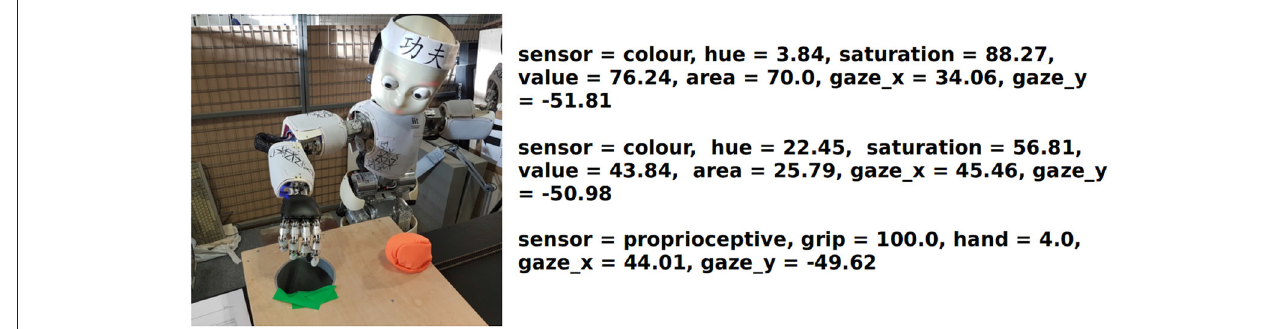
FIGURE 10 | Experimental set up for the iCub and perceived sensory information.